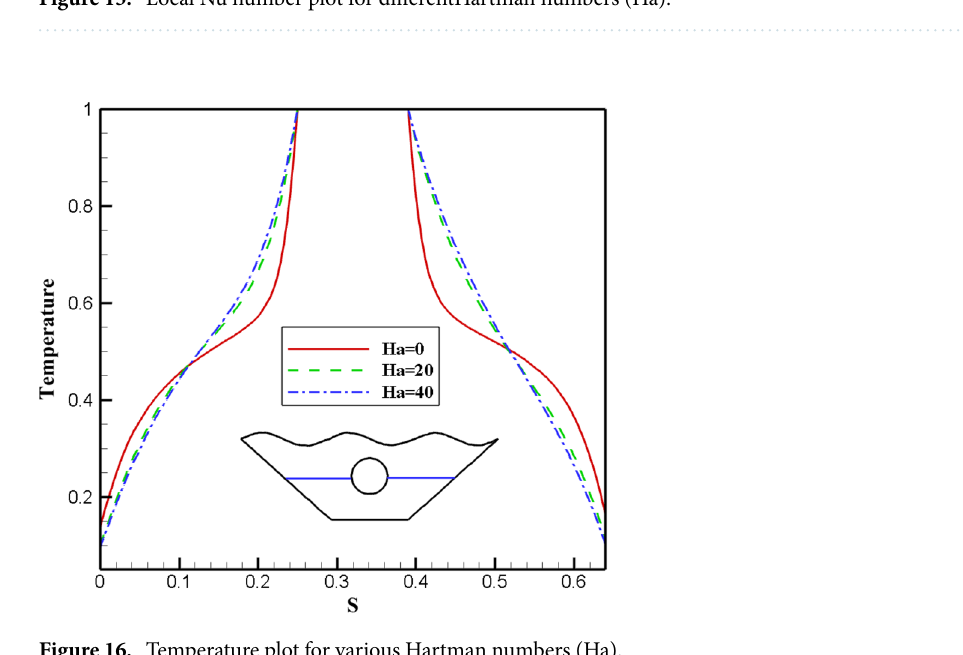
Figure 16. Temperature plot for various Hartman numbers